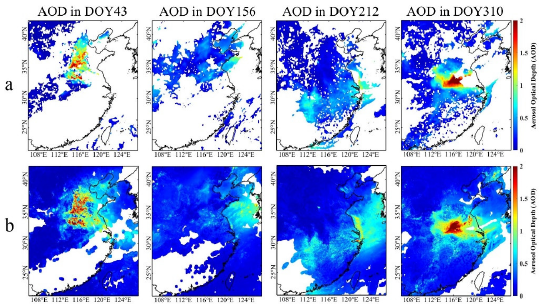
Figure 3 . Temporal variation of the yearly averaged completeness of the original Himawari/AHI hourly AOD Figure 1 . The AOD spatial distributions of (a) the original datasets (green line) and AOD datasets after NBME (red Himawari/AHI hourly AOD datasets and (b) AOD datasets after NBME in the study in DOYs 43, 156, 212, 310, respectively.